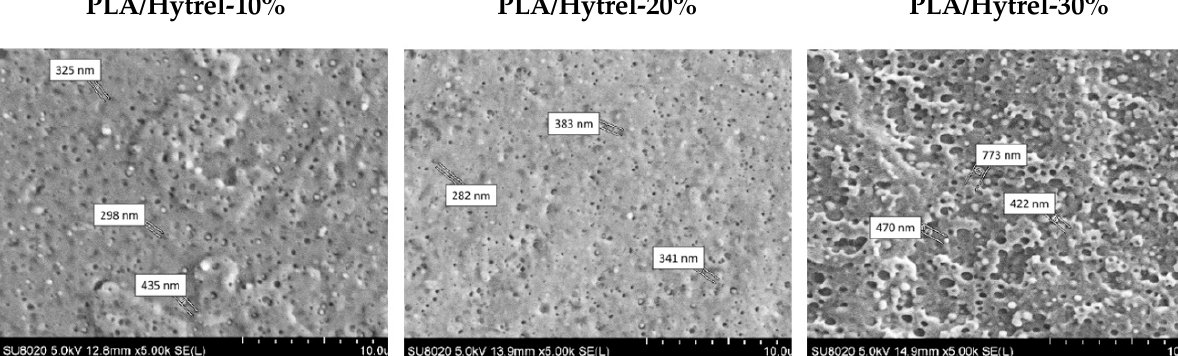
Figure 5. SEM images (magnification: × 5.00 k) of cryofractured surfaces of PLA/Hytrel blends for three different Hytrel contents (10%, 20%, and 30%).